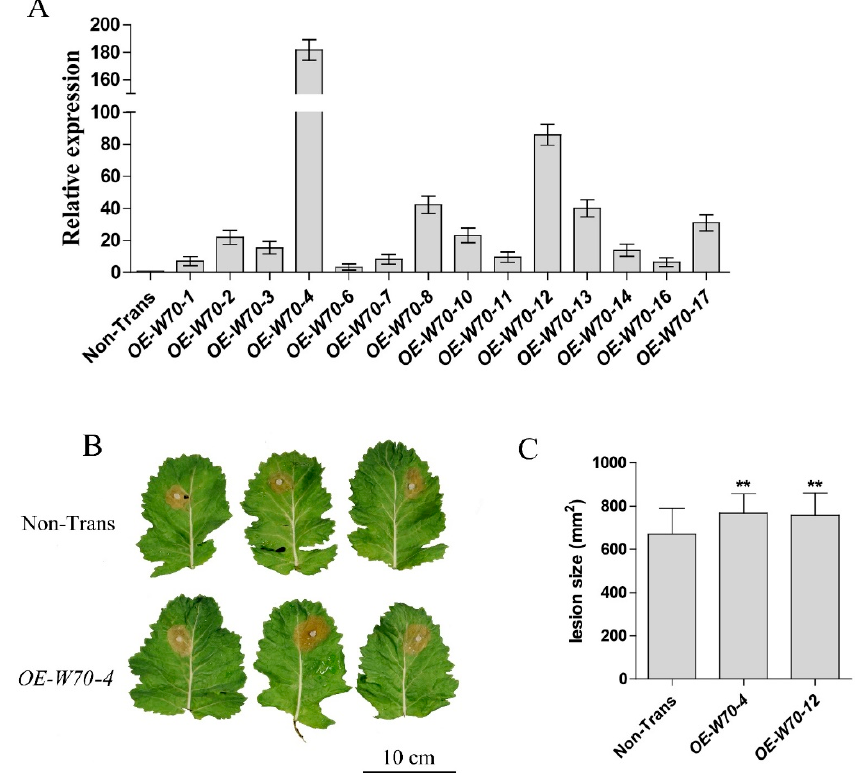
Figure 6. Expression analysis and lesion area on leaves of BnWRKY70 overexpression B . napus lines inoculated with S . sclerotiorum. ( A ) RT-qPCR analysis of BnWRKY70 expression in overexpression plants. BnActin7 was used as reference gene. The data shown are the mean of three independent experiments ± standard error (SE). ( B ) Representatives of disease symptom on the Non-Transgenic (Non-Trans), BnWRKY70 knockout lines. Leaves of 6-week-old plants were inoculated with S . sclerotiorum . Photos were taken 48 h post-inoculation. ( C ) Lesion area on leaves of BnWRKY70 overexpression lines. ** indicate that the means are statistically different ( p < 0.01).